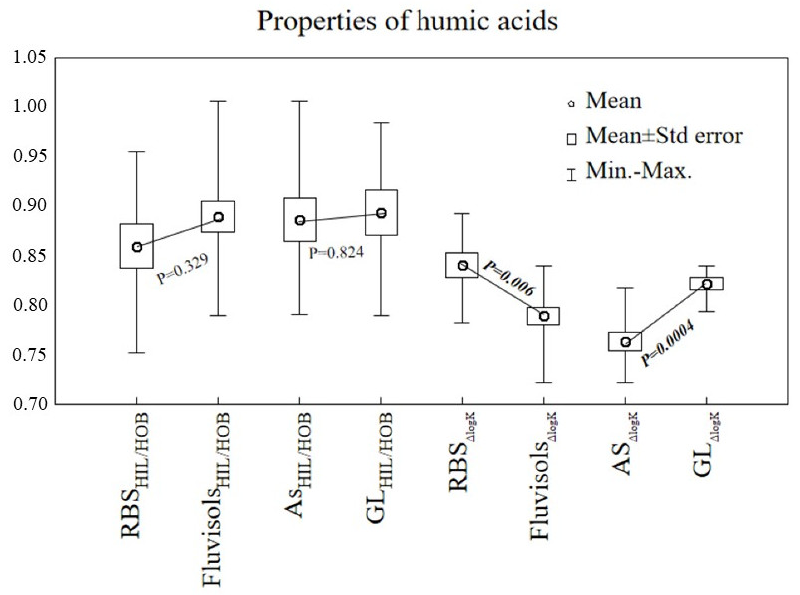
Figure 3. The hydrophilic–hydrophobic properties and parameters ∆ logK in humic acids isolated from riverbank sediments (RBS), arable soils (AS) and grassland soils (GL). 3.3. Spectrometric Parameters of Humic Acids in the UV–VIS Range The HA molecules isolated from grasslands had the lowest intensity absorbance at wavelengths of 280 nm (A 280 ), 465 nm (A 465 ) and 665 nm (A 665 ), being 3.66, 0.448 and 0.072, respectively (Table 4). The highest absorbance value of 3.99 was at 280 nm, reflecting the content of lignin-type compounds, and was obtained for the humic acids in the arable soils. It is also worth noting that, for the HA molecules isolated from riverbank sedi- ments, the highest degree of humification was obtained, as evidenced by the absorbance values at 665 nm, being 0.118. Table 4. Spectrometric properties of humic acids in the UV–VIS range of arable soils.